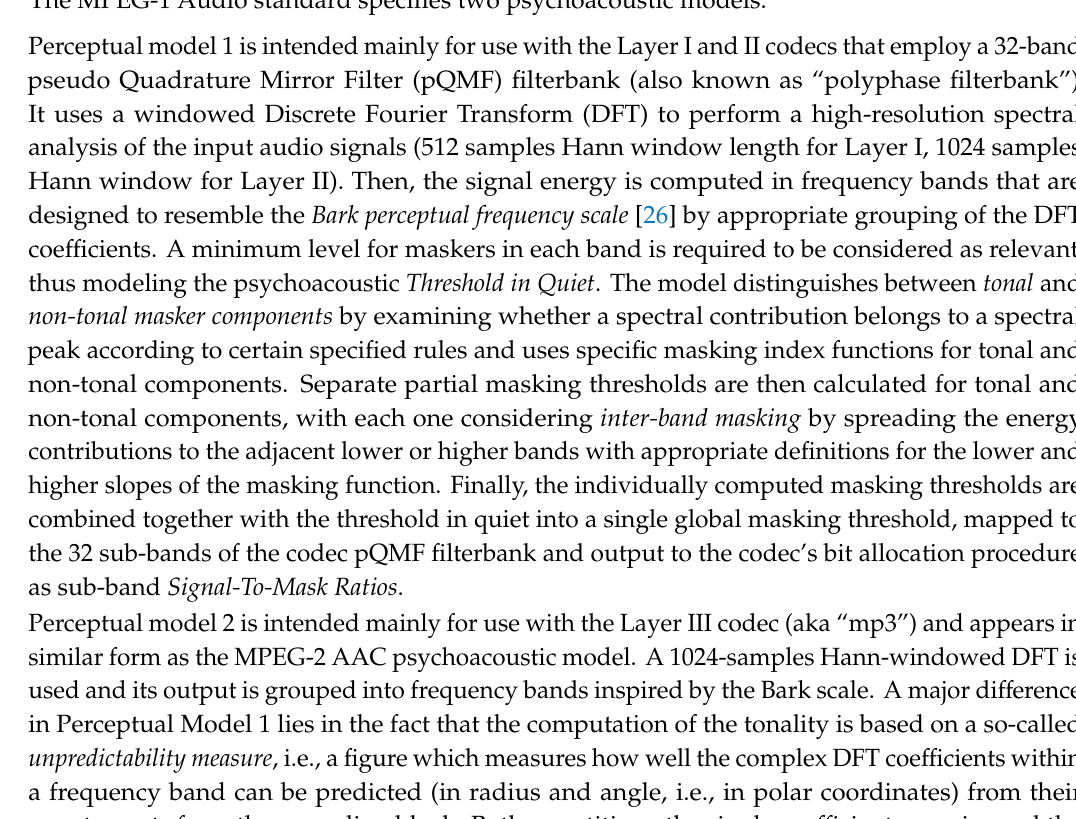
Figure 4. Illustration of temporal masking effects